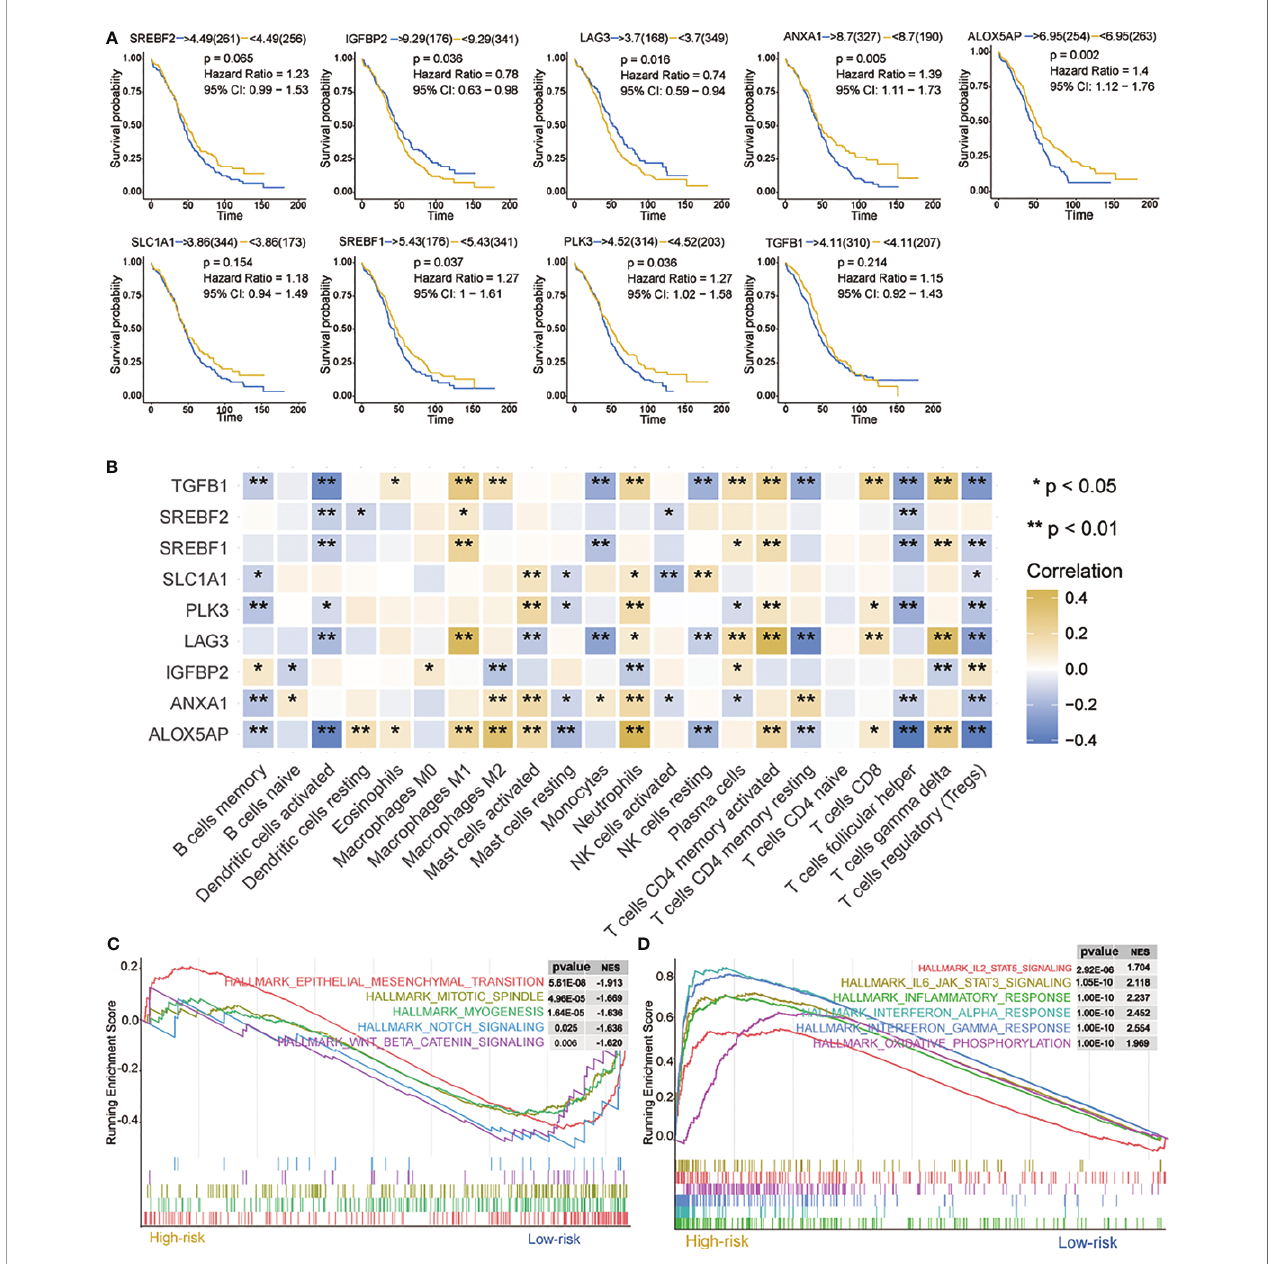
FIGURE 3 | Characteristics of 9 hypoxia signatures. (A) Prognosis of 9 hypoxia signatures. (B) Correlations between 9 hypoxia signatures and the distribution of immune cell in fi ltration. (C, D) GSEA enrichment in high- and low-risk groups. Normalized enrichment score (NES) > 1 and nominal p-value (NOM p-val) < 0.05 were considered signi fi cant. *P < 0.05, **P <